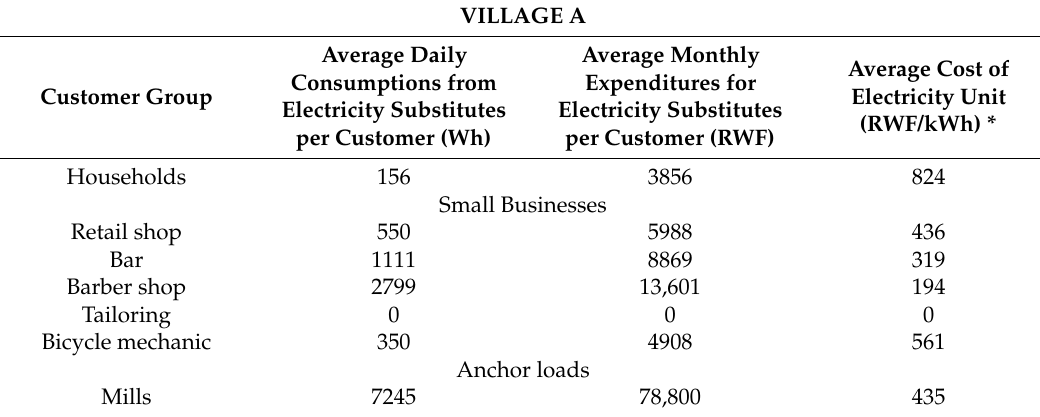
Table 3. Average consumptions and expenditures for electricity substitutes per